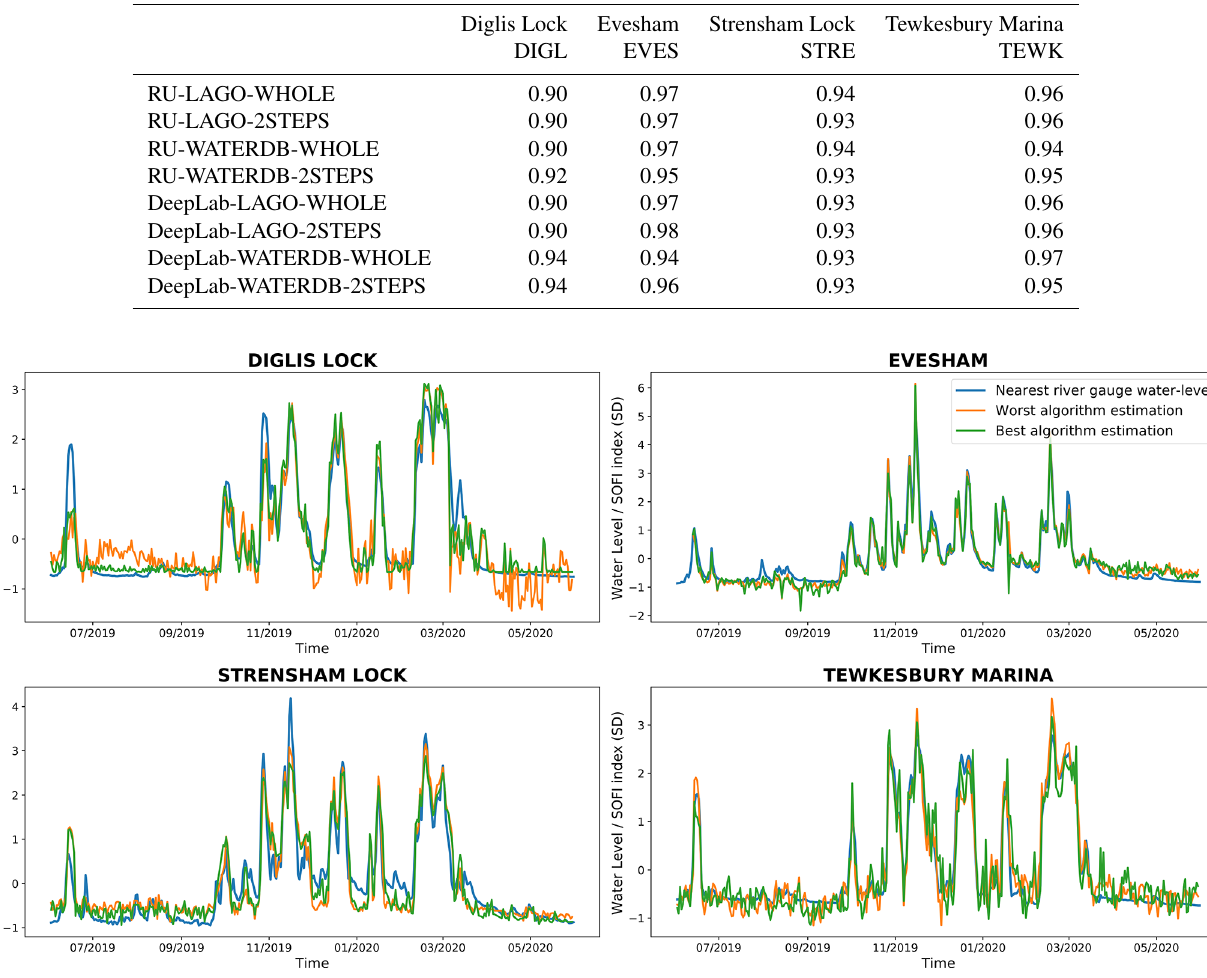
Figure 10. Standardised SOFI of the best window from the 4 × 4 grid in comparison with standardised water levels from nearby river